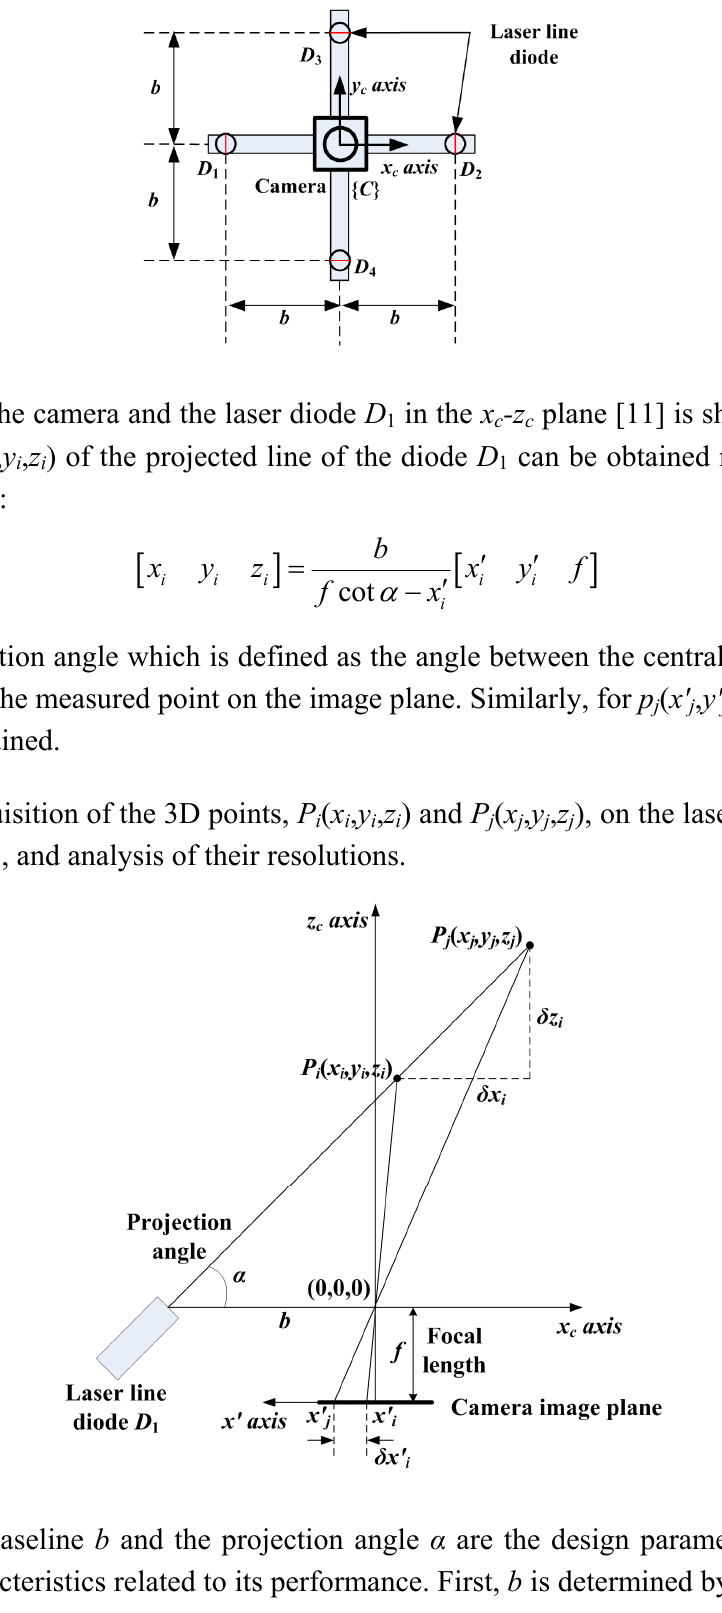
Figure 3. Front view of the 3D lug pose sensor with a monocular camera and four laser line diodes, D